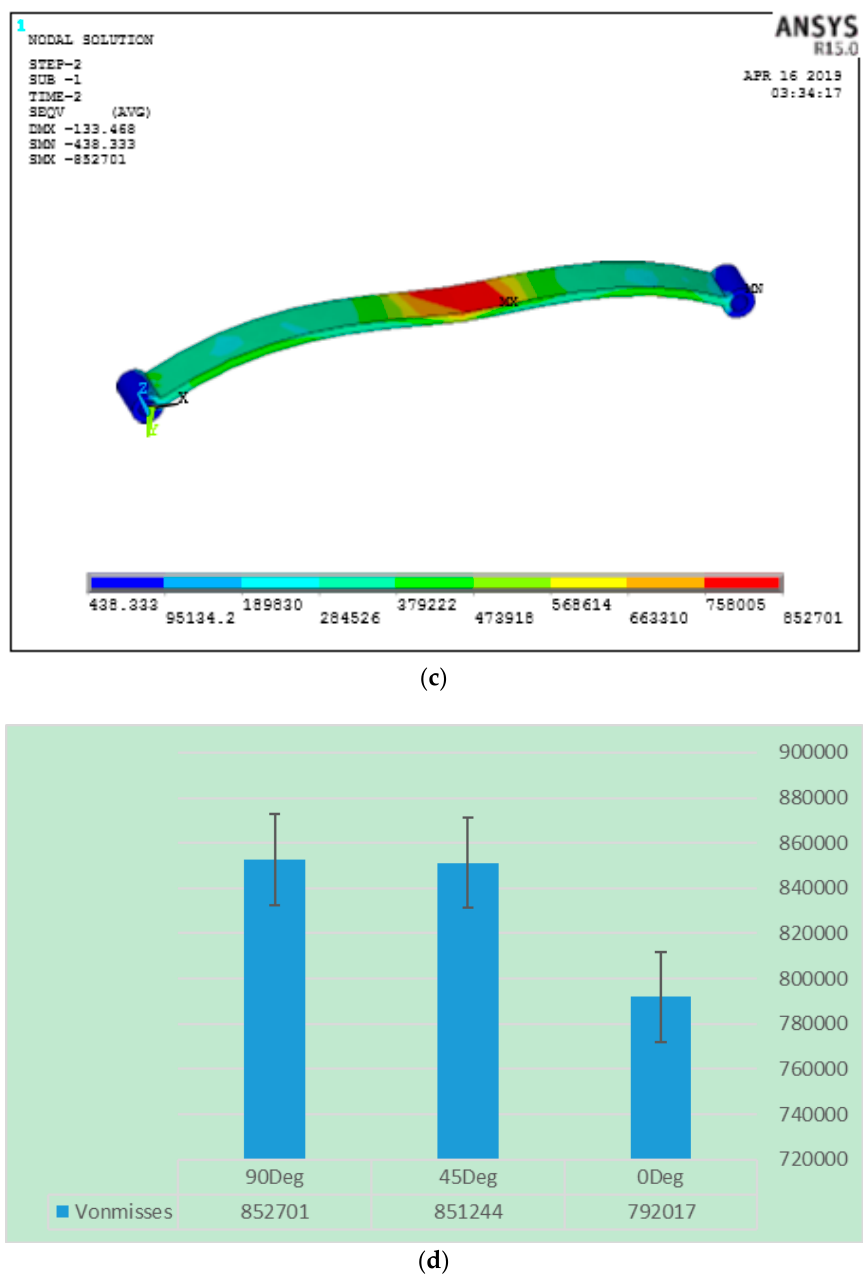
Figure 12. Von Mises stress for different fiber orientations ( a ) 0° (b) 45° (c) 90° ( d ) Vonmises Stresses.